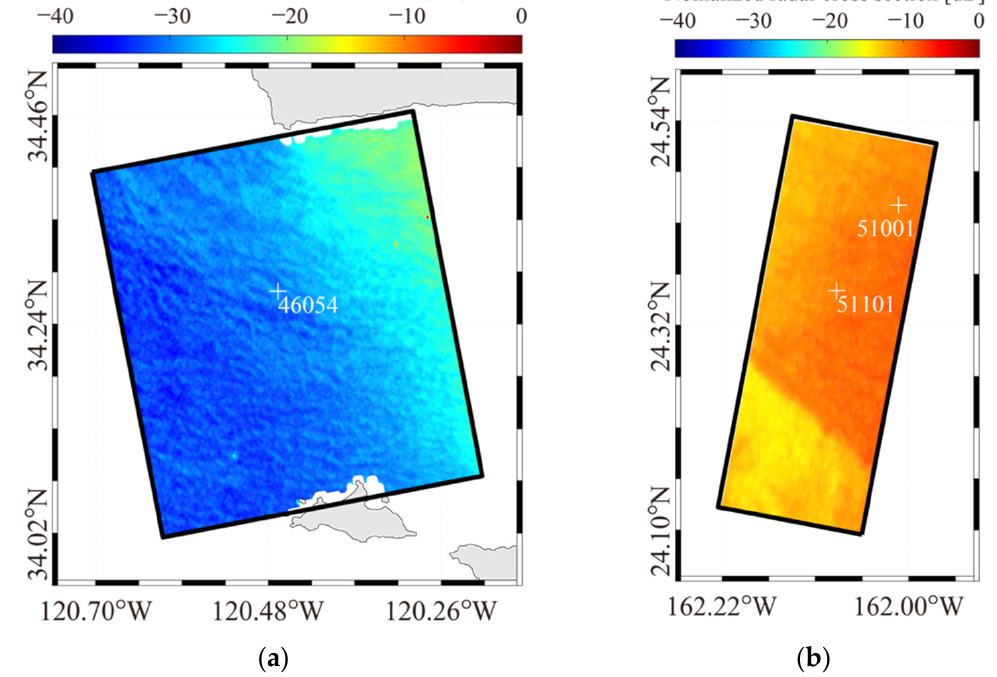
Figure 1. Synthetic aperture radar (SAR) measured normalized radar cross sections (NRCSs) of ( a ) a VV-polarized Gaofen-3 (GF-3) image acquired at 01:58 UTC on 5 May 2017 and ( b ) a TerraSAR-X (TS-X) image acquired at 16:53 UTC on 3 August 2009. Note that the three buoys located in these images are marked by white crosses.